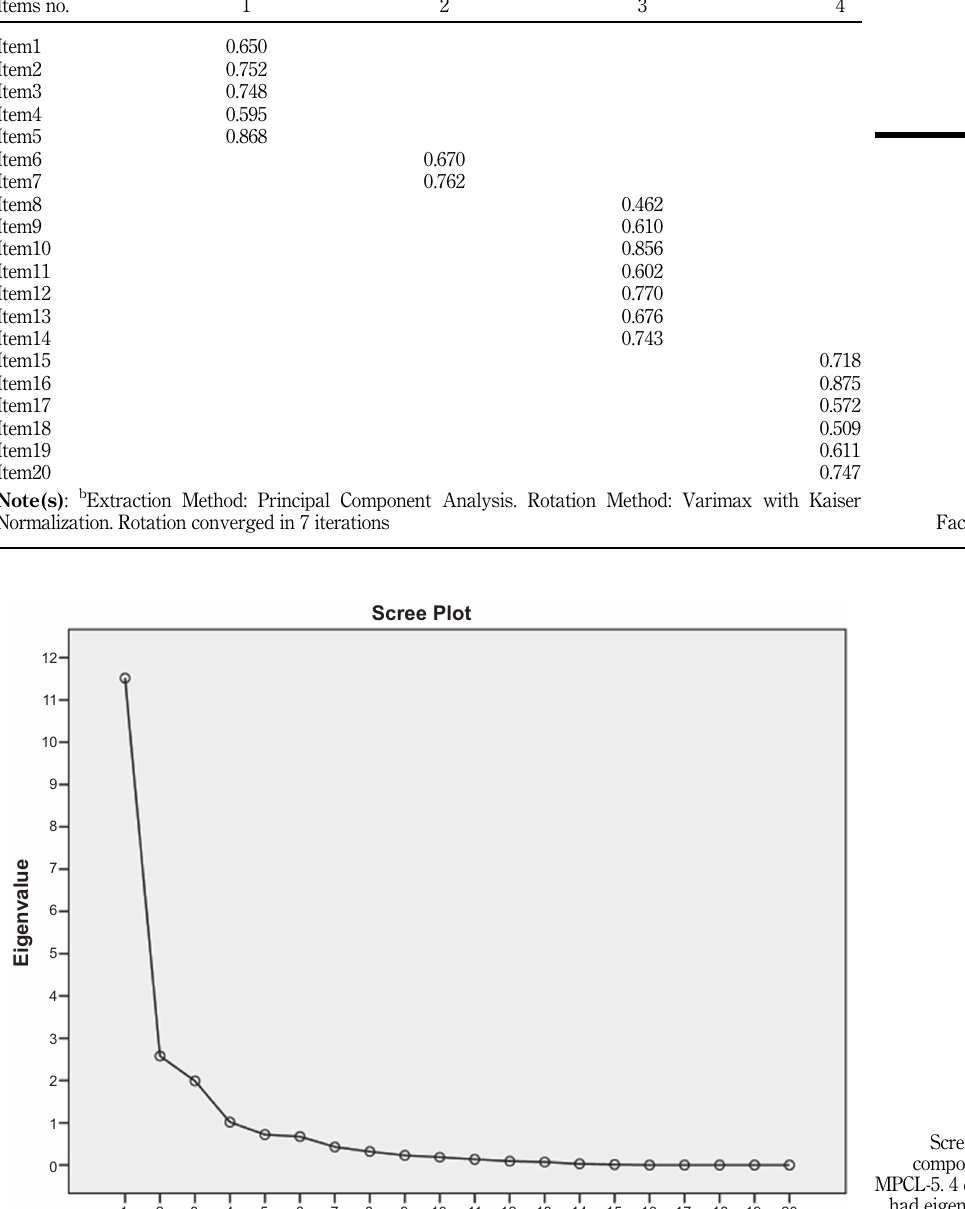
Figure 1. Scree plot of the components of the MPCL-5. 4 components had eigenvalues of at least one and